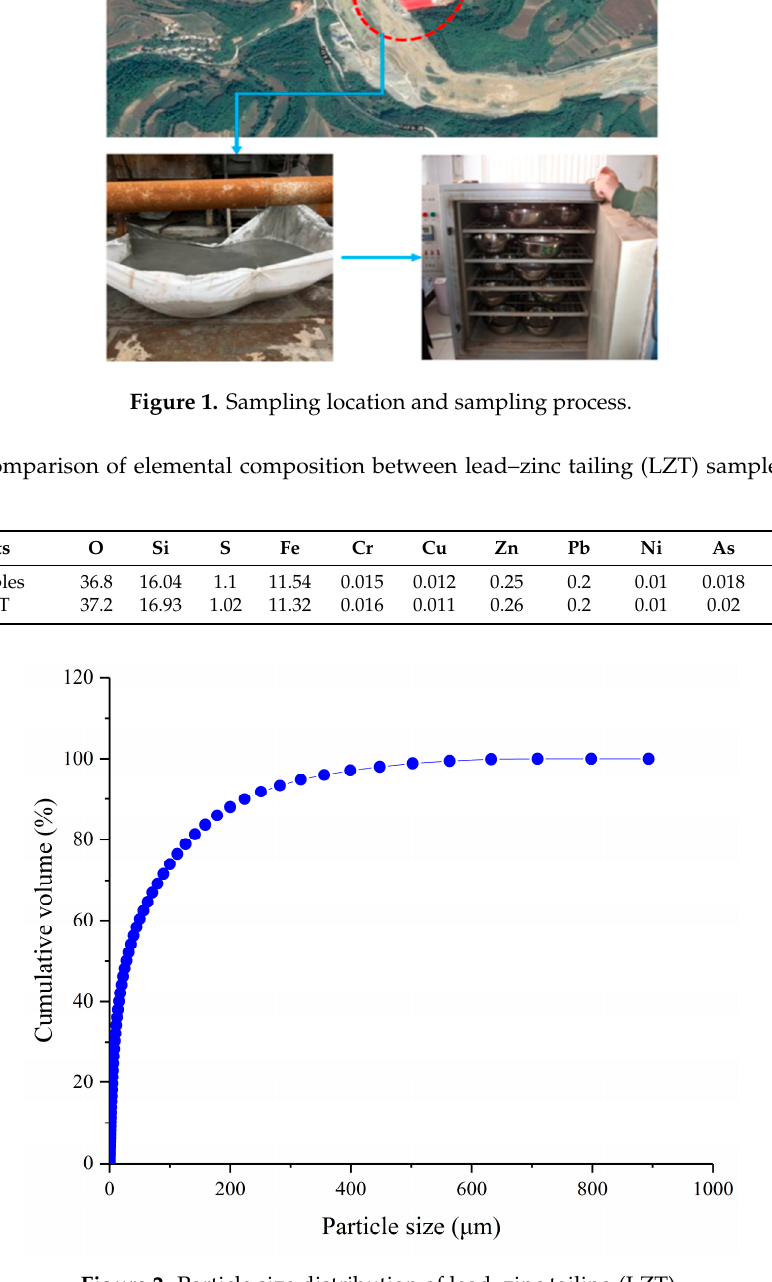
Table 3. Physical properties of lead–zinc tailing (LZT) . Physical Properties